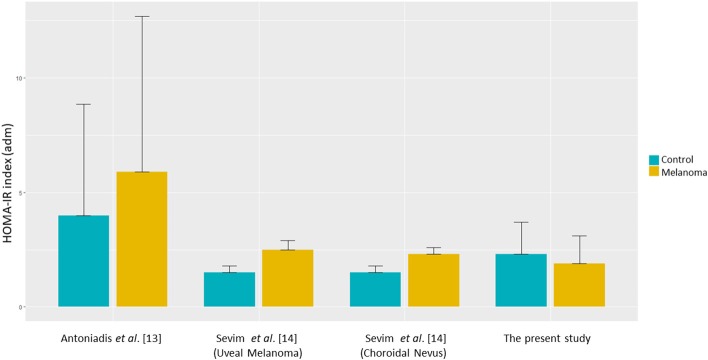
HOMA-IR values in patient vs. control subgroups among the avalaible studies.